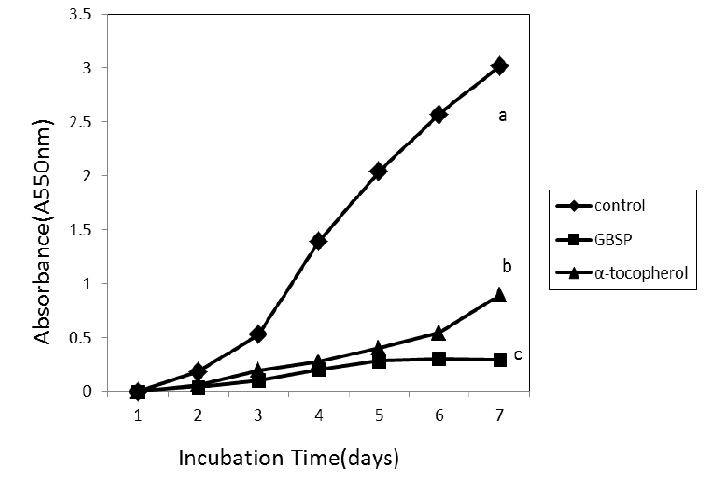
Figure 5. Lipid peroxidation inhibitory activity of GBSP. The activity was measured in a linoleic acid oxidation system for 7 days. α -Tocopherol was used as positive control. a–c Means having same superscript are not different ( p > 0.05). The results are shown as means ± SD (n =